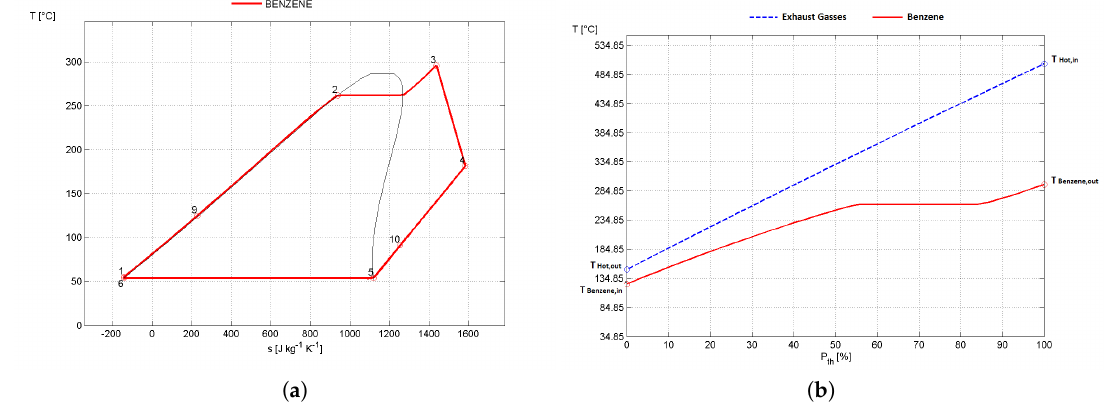
Figure 3. ( a ) T-sand ( b ) T-Qdiagram of the recuperative ORC unit designed with measured data and employing benzene as the working